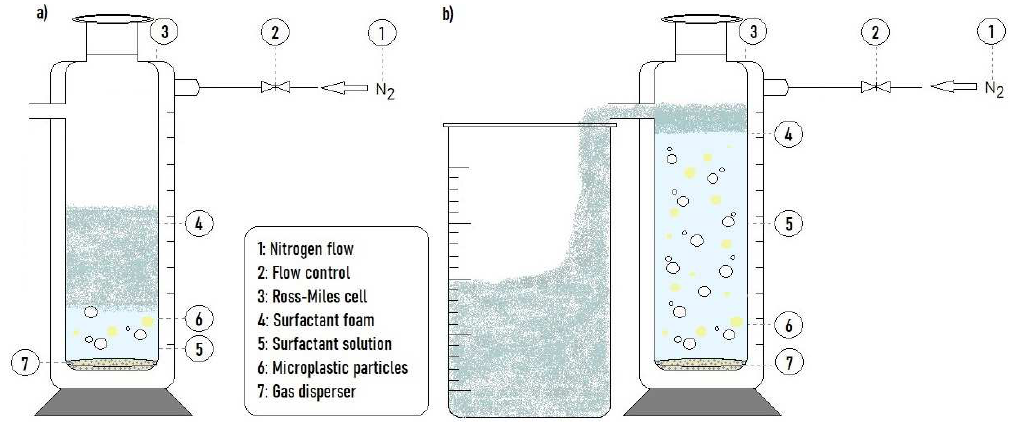
Figure 2. ( a ) Scheme for a sparging-test cell with a height of 20 cm and an ID of 4 cm. ( b ) Scheme of operation of sparging-test cell for flotation experiments. Typical conditions for the experiment: surfactant solution of 30 mL, 5–10 mL/min gas flow rate.